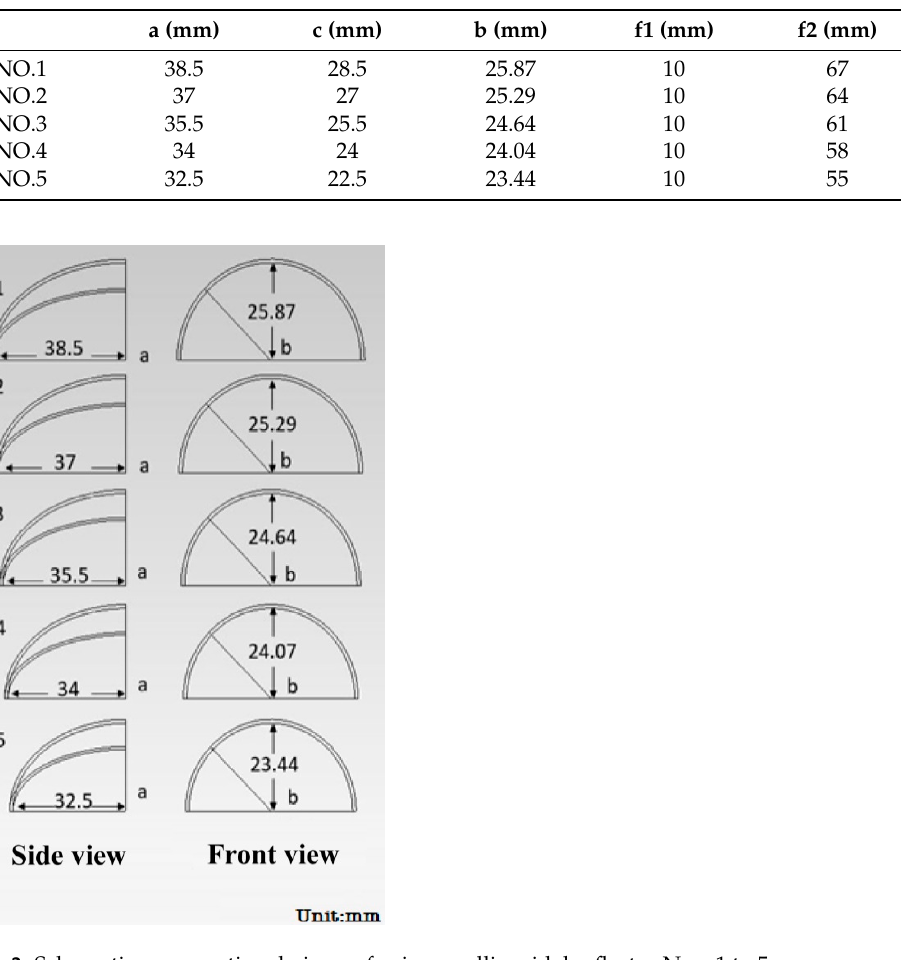
Table 1. Parameters of the primary ellipsoidal reflectors used in this study.